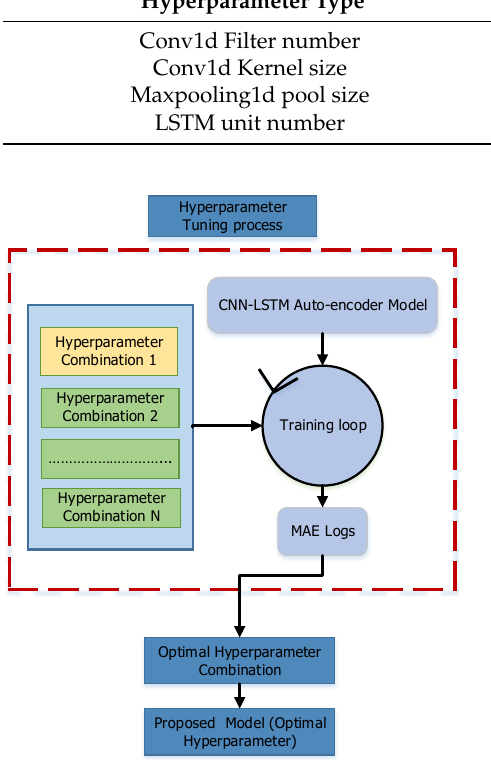
Figure 3. Hyperparameter